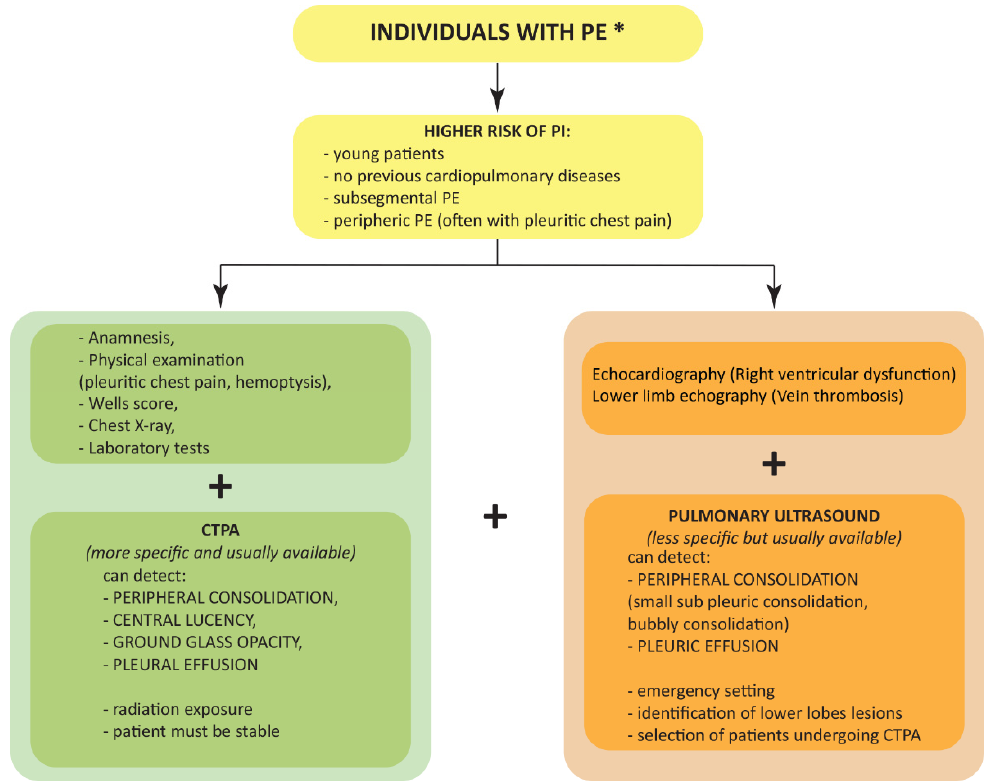
Figure 3. Flow diagram showing the proposed algorithm for the diagnosis of pulmonary infarction in case of pulmonary embolism. * As diagnosed via current guidelines. CTPA, computed tomography pulmonary angiography; PE, pulmonary embolism; PI, pulmonary infarction.